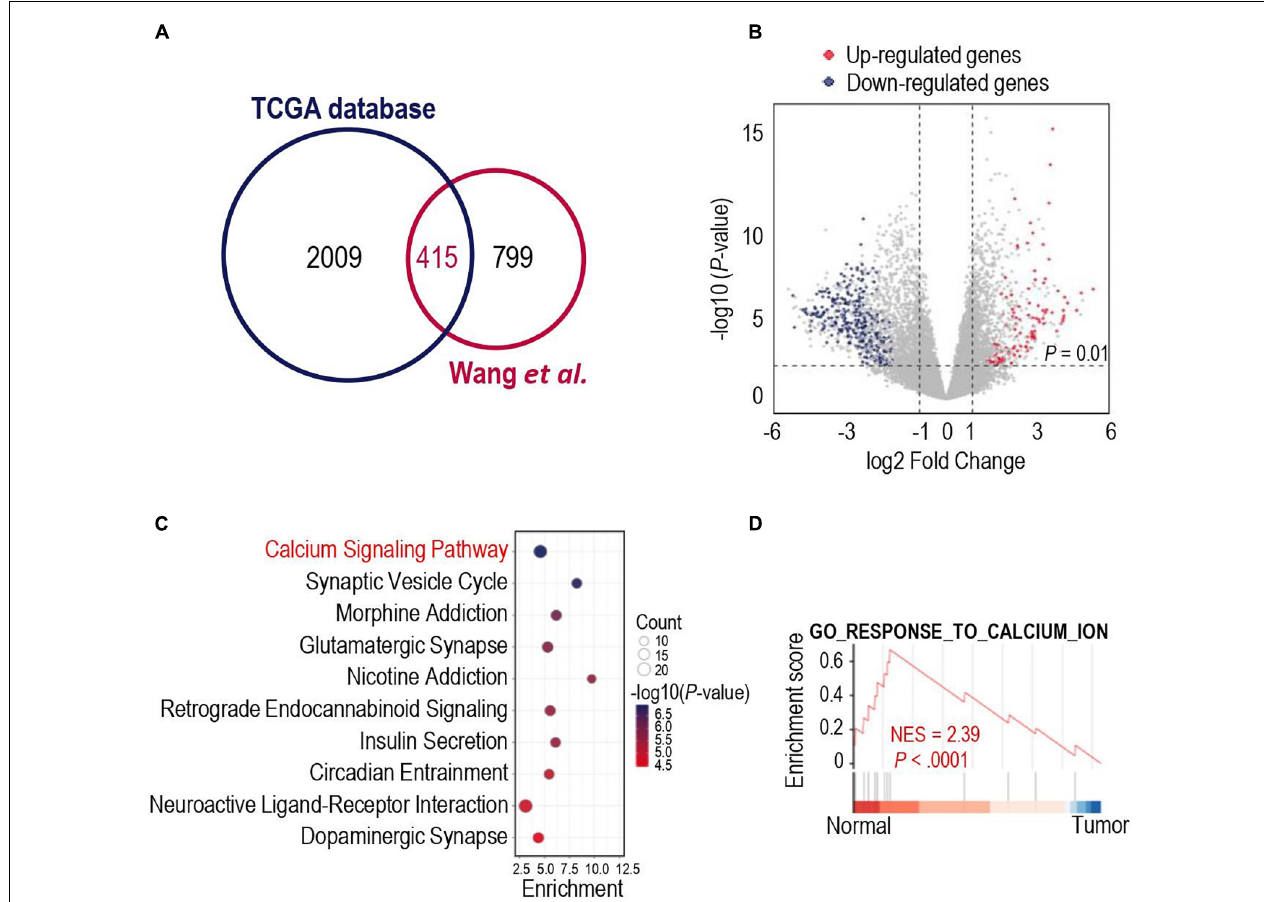
FIGURE 1 | Gene expression differences in human glioma and human normal brain. (A) Venn diagram showed the intersected differentially expressed genes (iDEGs) from two independent datasets. (B) Volcano plots showed the up-regulated and down-regulated iDEGs in The Cancer Genome Atlas (TCGA) database (| log 2 Fold change| > 1 and p- value < 0.01). (C) Top 10 enriched Kyoto Encyclopedia of Genes and Genomes (KEGG) pathways by the iDEGs. (D) Gene set enrichment analysis (GSEA) discovered the calcium signaling pathway enriched in the normal brain cases in the TCGA